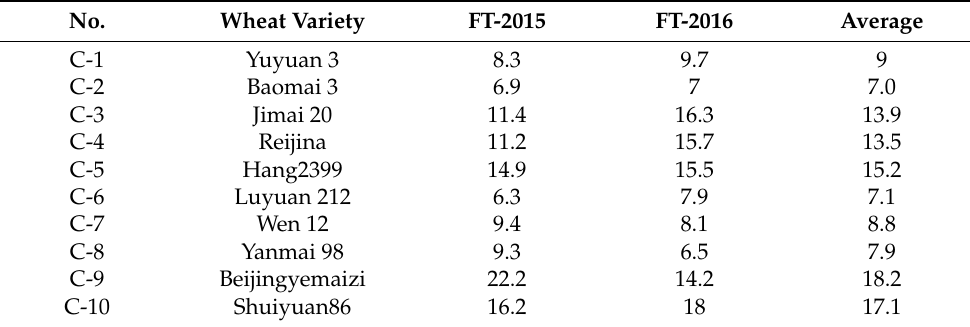
Table 1. Wheat varieties used in CCD7 gene cloning.